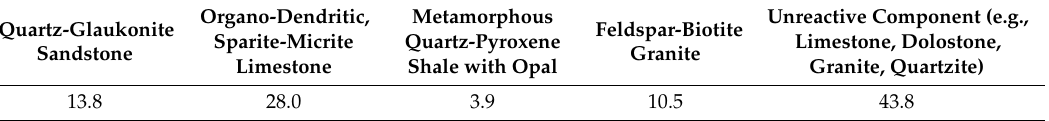
Table 1. Gravel petrographic composition (%).